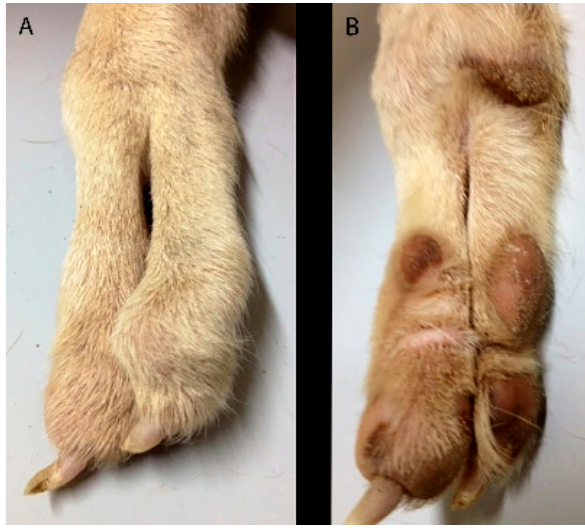
Figure 9. Case 4. Dorsal ( A ) and palmar ( B ) views of the right forelimb. Note the deformity of the